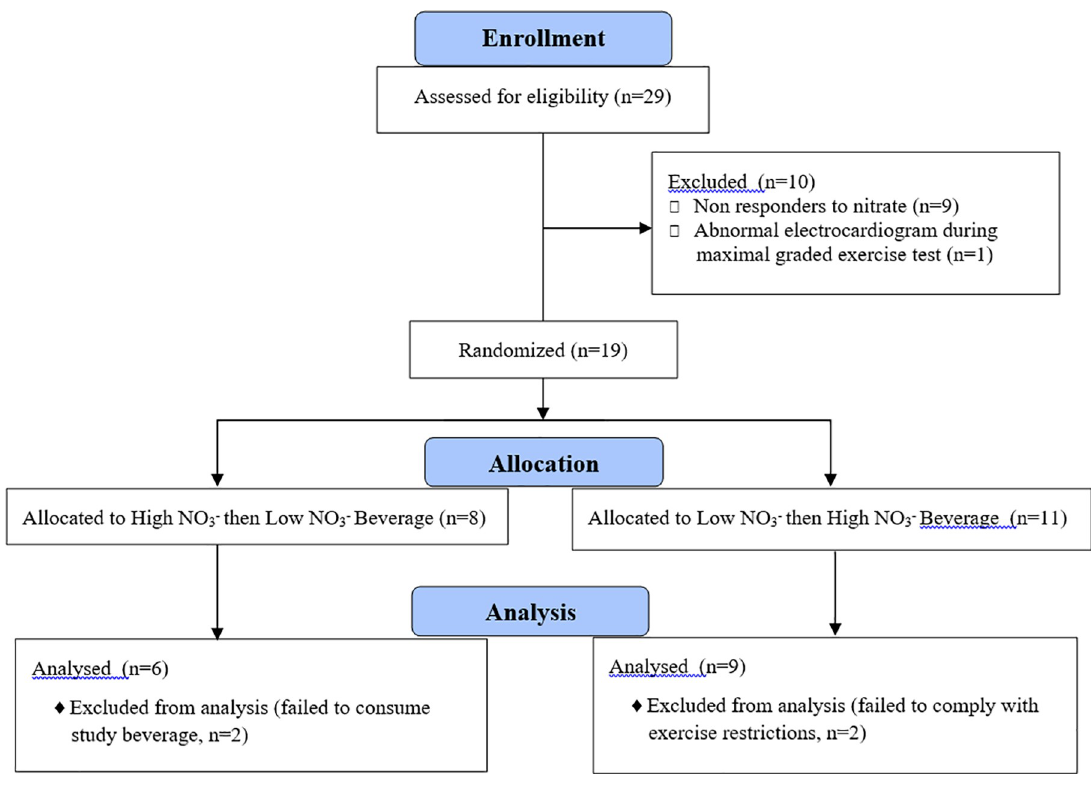
Fig 1. Subject flow through study.